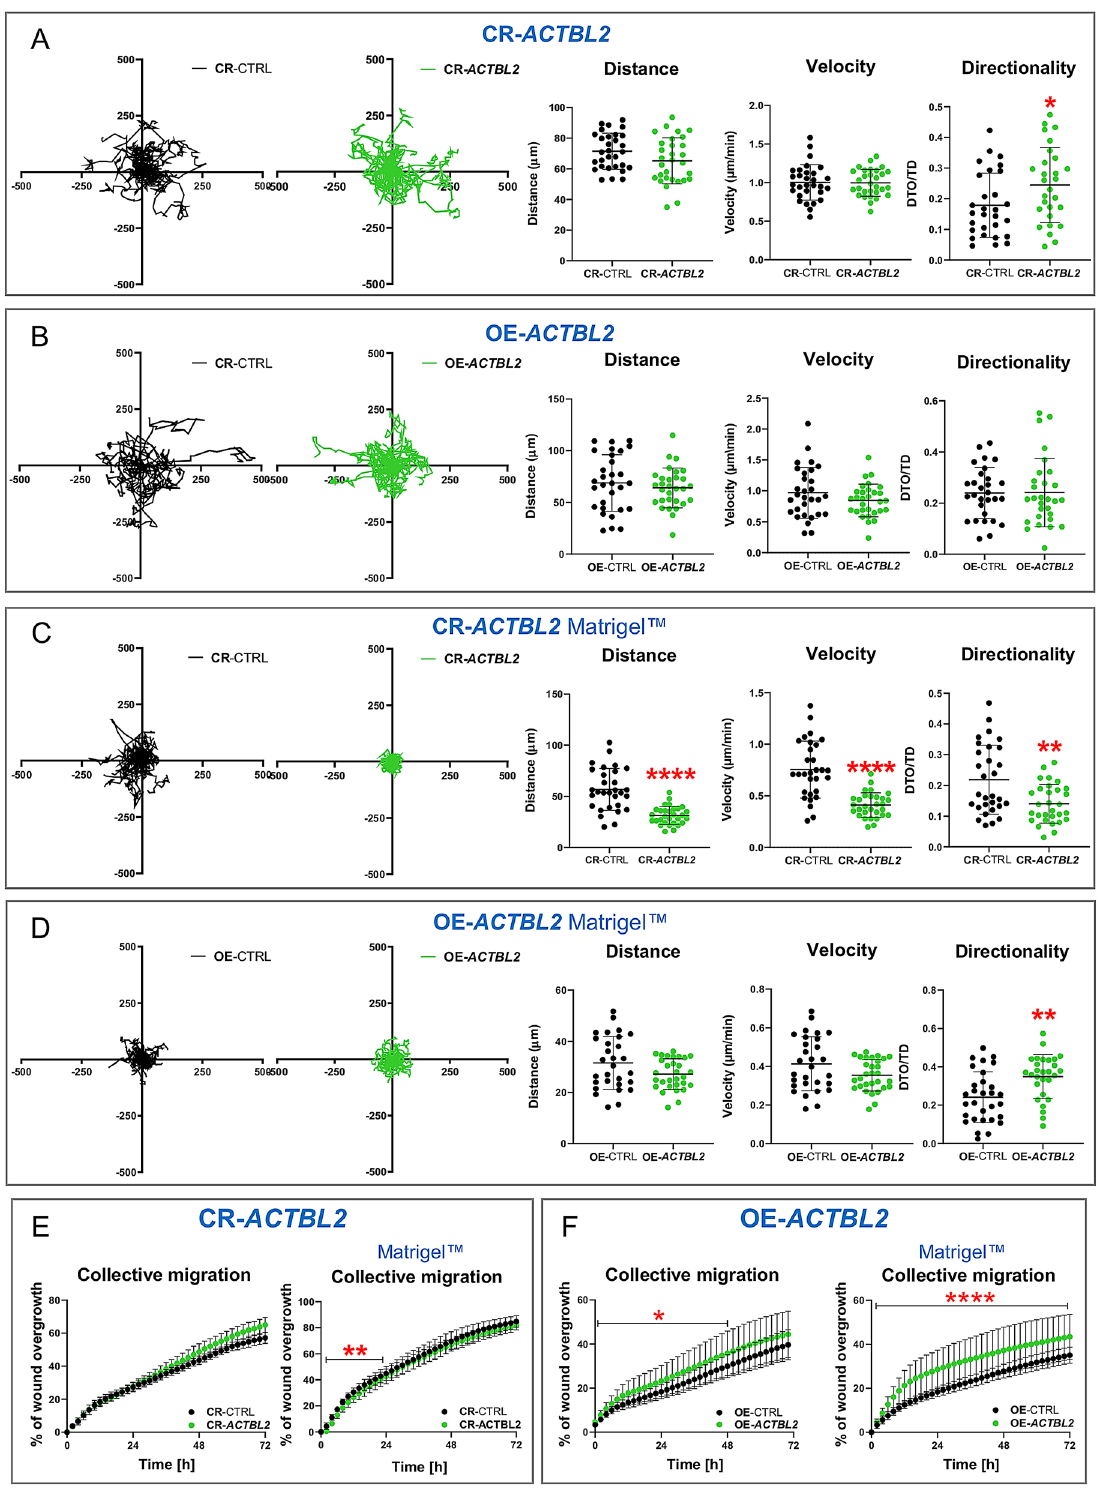
Figure 7. The lack of actbl2 and actbl2 overexpression differently affects the 2D migration of A375 cells. ( A , B ) Spontaneous 2D migration of control cells and cells either devoid of actbl2 or overexpressing actbl2. The cells were seeded onto IncuCyte ImageLock plates. The migration assay was performed using IncuCyte Live Cell Analysis Imaging System for 72 h with images taken every 2 h. Based on single trajectories of the cells, distance, velocity, and directionality were measured (n = 30). ( C , D ) As presented in A and B, an analogous analysis was done for the same clones seeded into plates coated with Matrigel (n = 30). ( E , F ) The control clones and CR- ACTBL2 and OE- ACTBL2 clones were subjected to collective migration assay for 72 h (n = 3). The cells were seeded on non-coated or Matrigel-coated substratum. Representative photomicrographs are presented in Fig. S15. Results are expressed as the mean ± SD; p ≤ 0.05 (*), p ≤ 0.01 (**), p ≤ 0.0001